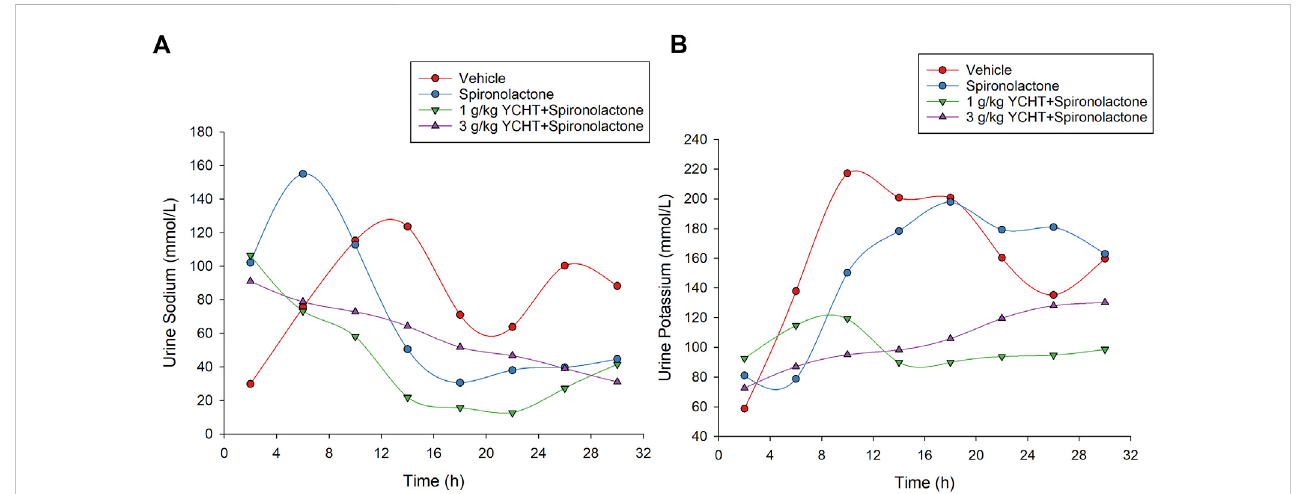
FIGURE 5 Urinesodium andpotassiuminthevehicle,spironolactone, 1 g/kgYCHTwithspironolactone, and 3 g/kgYCHTwith spironolactone groupsduring 32 h. (A) The urine sodium was higher for the fi rst 4 hours in the spironolactone, 1 g/kg YCHT with spironolactone, and 3 g/kg YCHT with spironolactone groups. The urine sodium in the spironolactone group reached the highest level during 4 – 8 h, while it was decreased in the 1 g/kg YCHT and 3 g/kg YCHT with spironolactone groups. (B) The urine potassium in the spironolactone group was lowest during 4 – 8 h and then elevated as compared to the vehicle groups to 32 h. The urine potassium in the 1 g/kg YCHT and 3 g/kg YCHT with spironolactone groups ranged from 72.5 to 130.2 mmol/L over 32